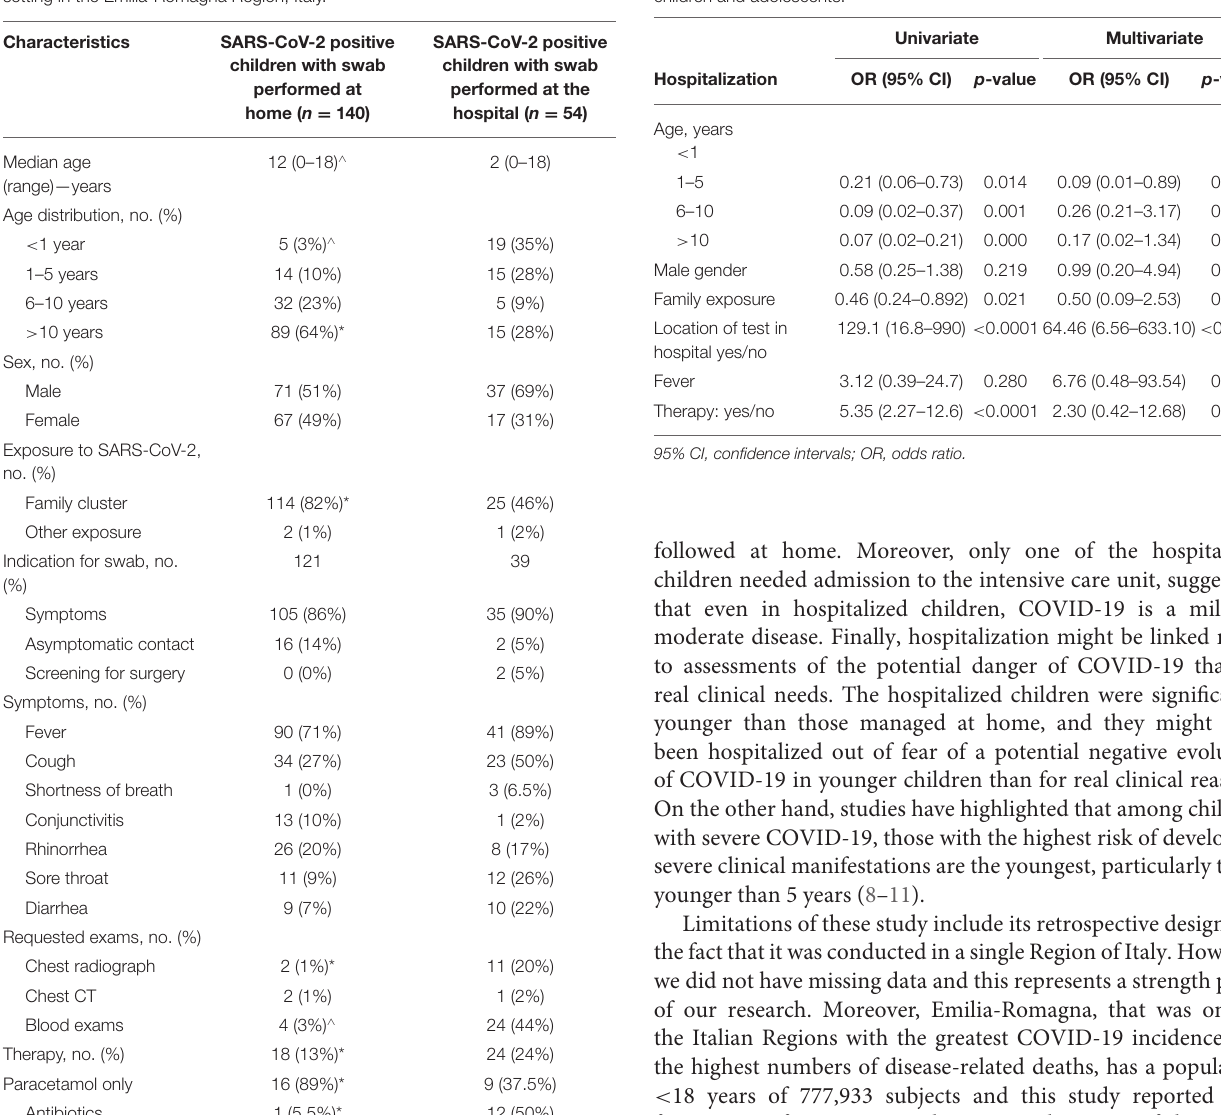
TABLE 3 | Univariate and multivariate logistic regression analysis showing association between different factors and hospitalization in SARS-CoV-2 positive children and